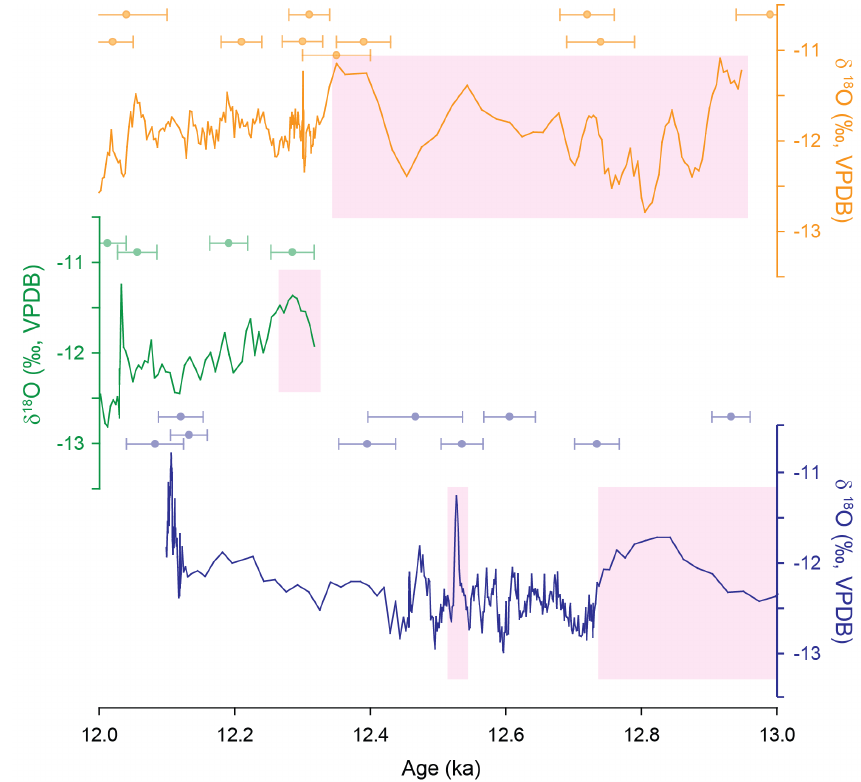
Figure 4. δ 18 O variability of the TR samples LAS 1 (orange), LAS 21 (green) and LAS 2 (blue) in their overlapping sections. All samples are plotted based on the modelled ages. 230 Th ages with their corresponding errors are plotted above each δ 18 O time series. Pink rectangles indicate aragonite